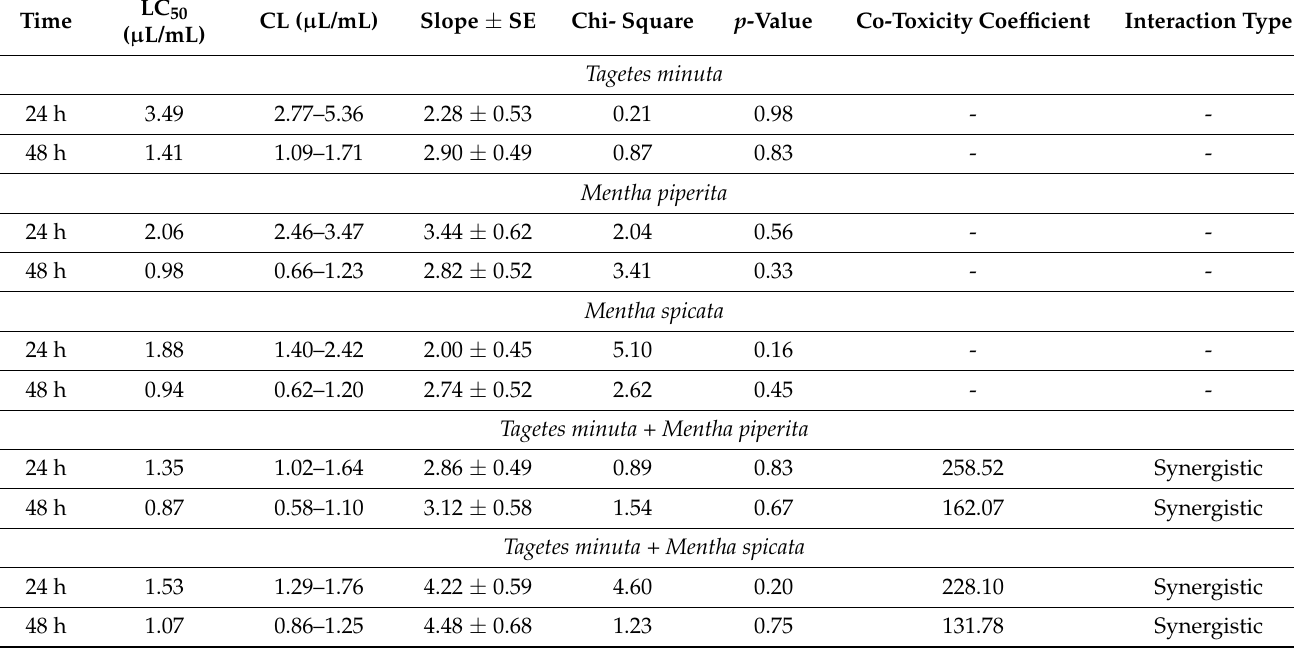
Table 1. Fumigant toxicity of essential oils and their combinations against Callosobruchus chinensis